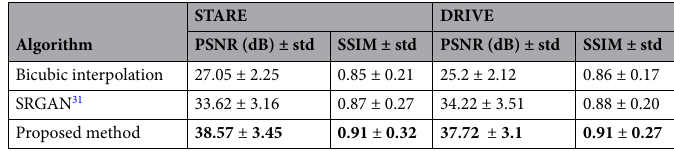
Table 4. Results on retinal images dataset. Significant values are in